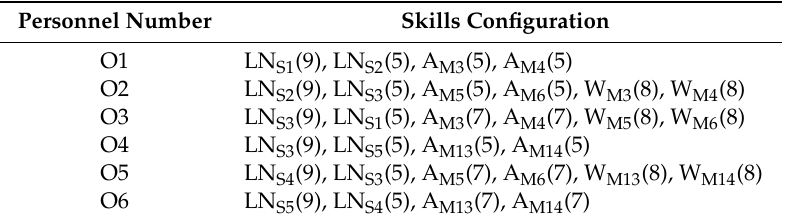
Table 2. Personnel skills configuration.